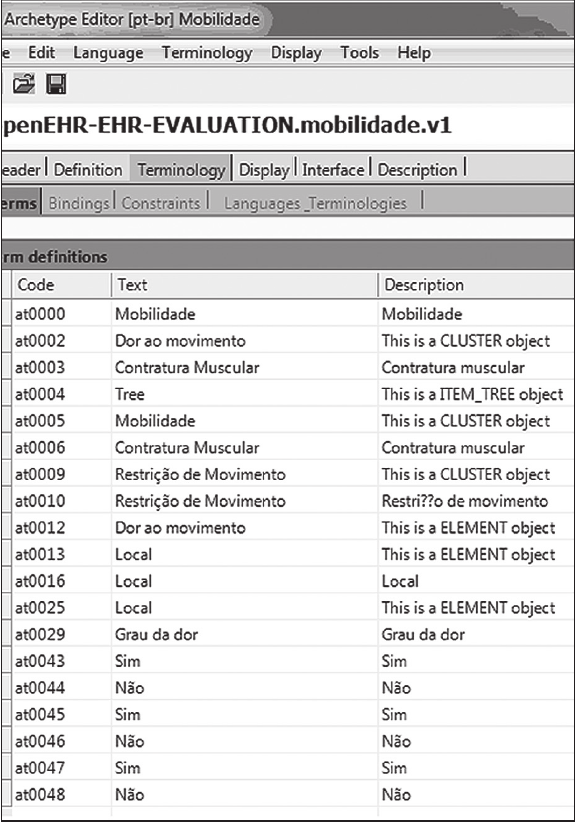
Figura 3 - Terminologia do arquétipo "Mobilidade" Fonte: Dados da